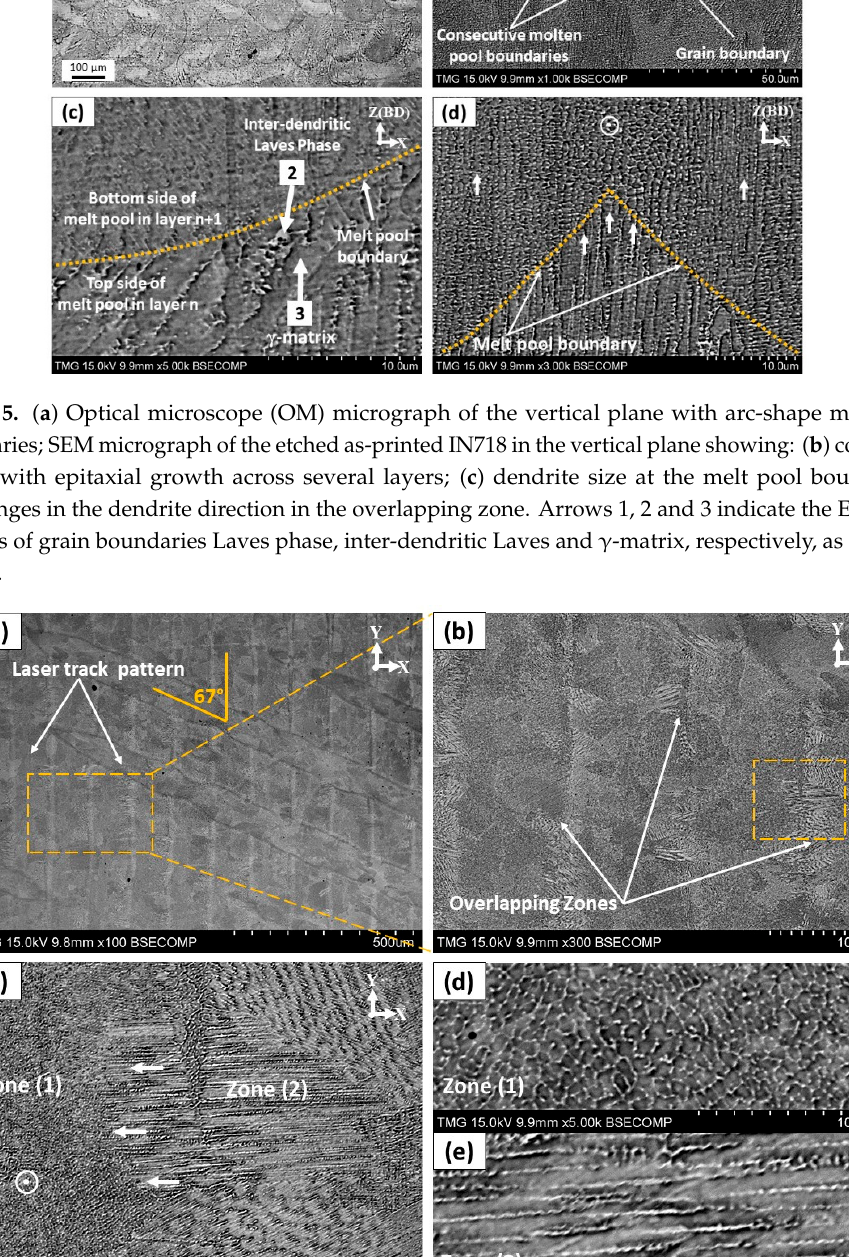
Figure 6. SEM micrograph of the etched as-printed IN718 in the horizontal plane showing: ( a ) the laser beam track and scanning strategy; ( b ) high magnification view for the area marked in ( a ); ( c–e ) changes in the dendrite directions in the horizontal overlapping zone as indicated in ( b